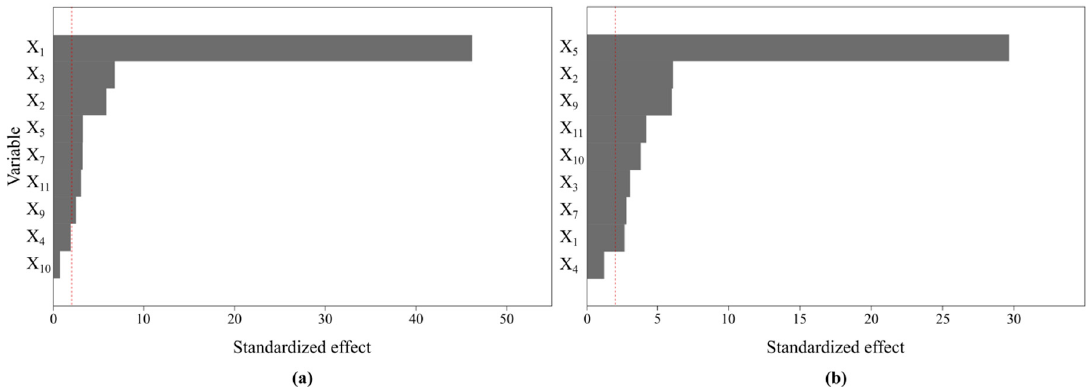
Figure 2. Pareto charts of the standardized effects of process parameters on ( a ) dry weight of cellulose and ( b ) glucose conversion into cellulose. The X symbols correspond to factors, where X 1 is bioreactor area, X 2 -cultivation time, X 3 -age of inoculum, X 4 -s/v ratio, X 5 -glucose concentration, X 7 -air-flow ratio, X 9 -volume of inoculum, X 10 -pH, and X 11 -humidity of air. The red line is a reference line at 2.056.